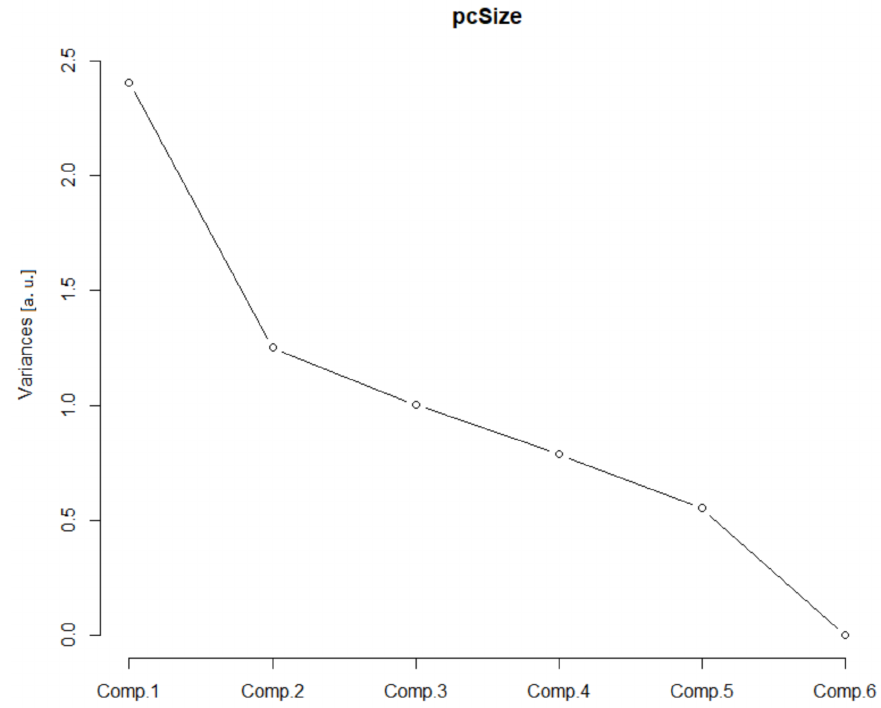
Figure 2. Size scree plot. The relationship between the variances (eigenvalues) and principal compo- nents for the size for the analyzed sample of astrocytes in the given group.